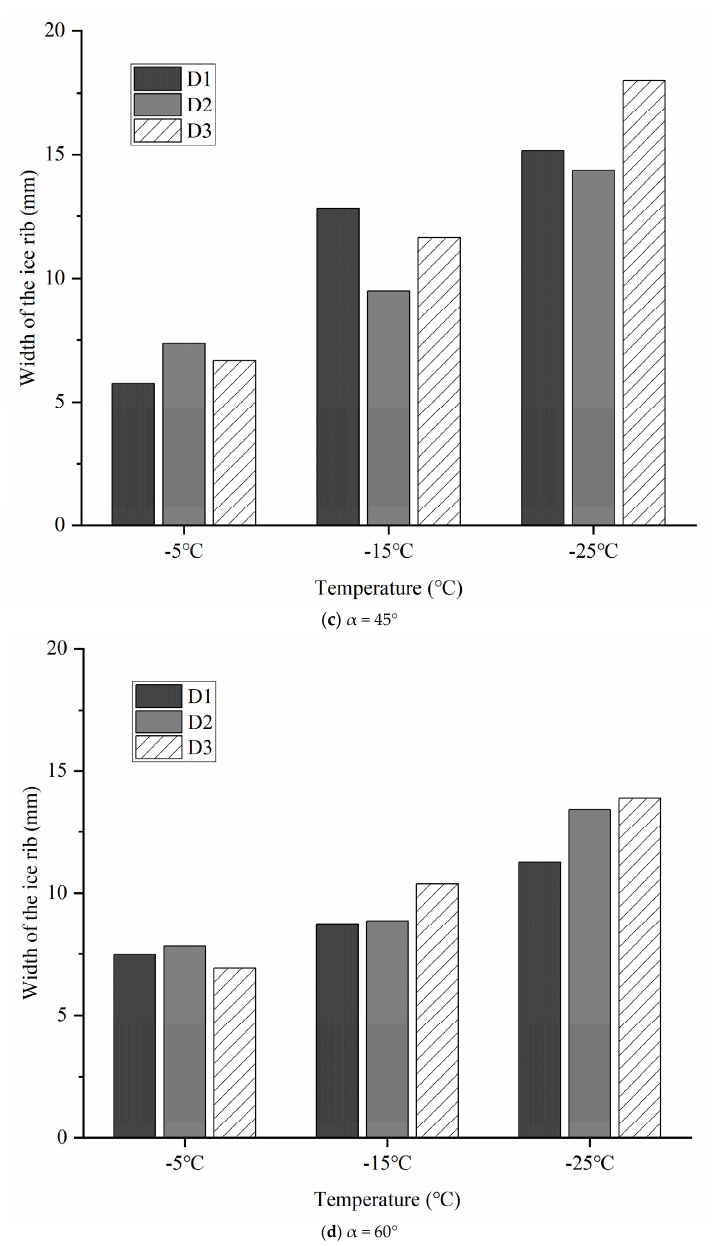
Figure 9. ( a – d ) In fl uence of ambience on ice rib width.